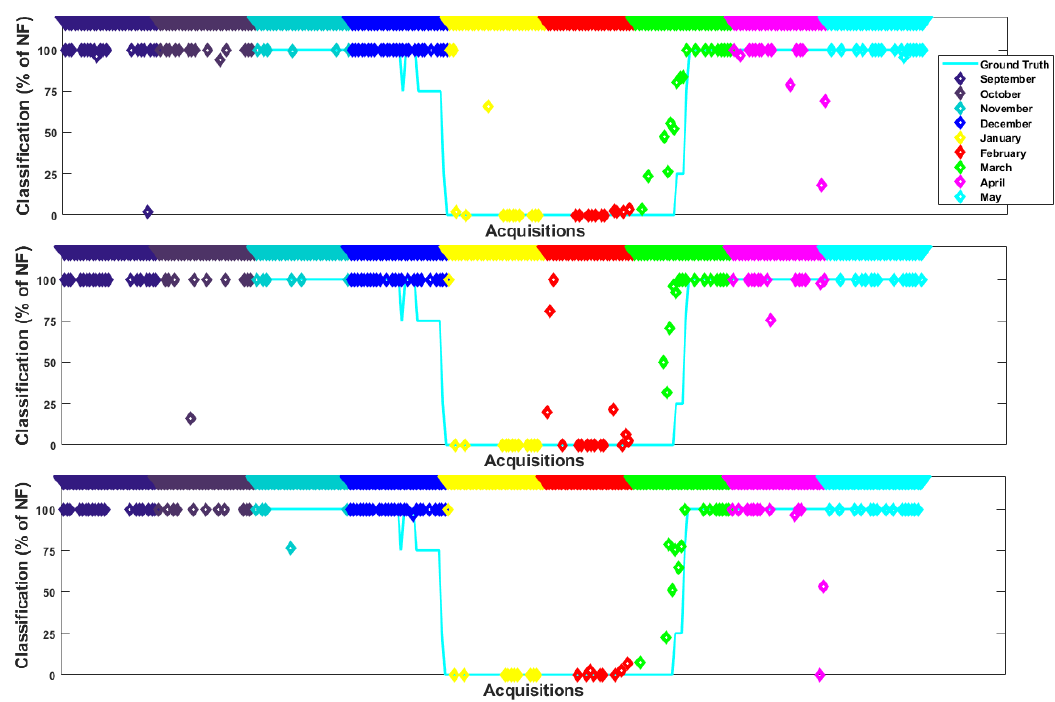
Figure 13. MODIS ( top ) and VIIRS ( middle ) timeline results of lake Sihl for full winter 16–17 using linear kernel. A timeline of the MODIS snow and ice product ( bottom ) is also plotted for comparison with our results and the webcam-based ground truth. In all timelines, the x -axis shows all dates that are at least 30% cloud-free in chronological order and the respective results [% of Non-Frozen (NF) pixels] are plotted on the y -axis.